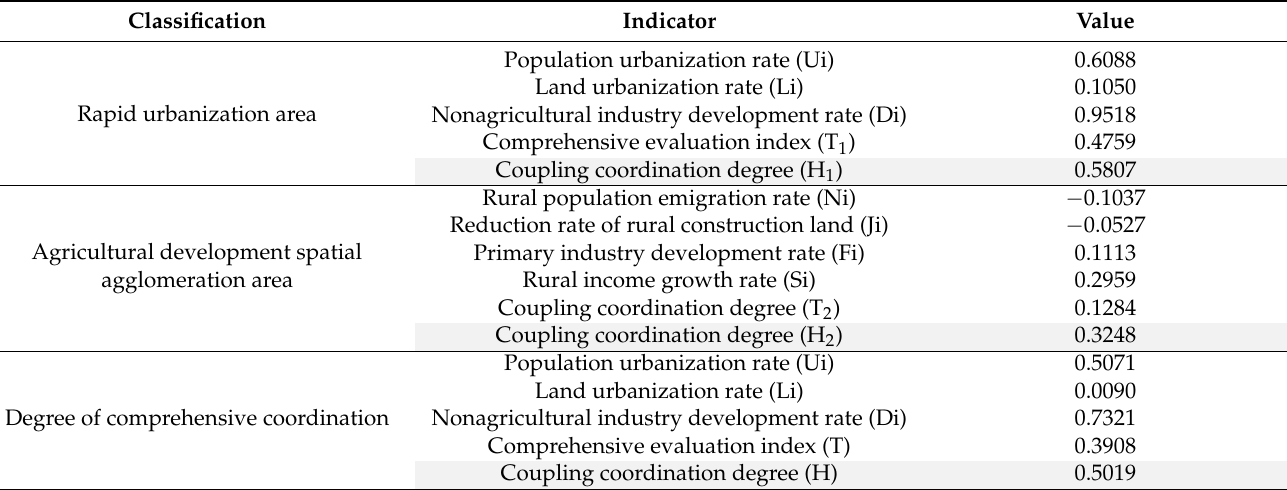
Table 3. Coupling coordination degree of PLI in